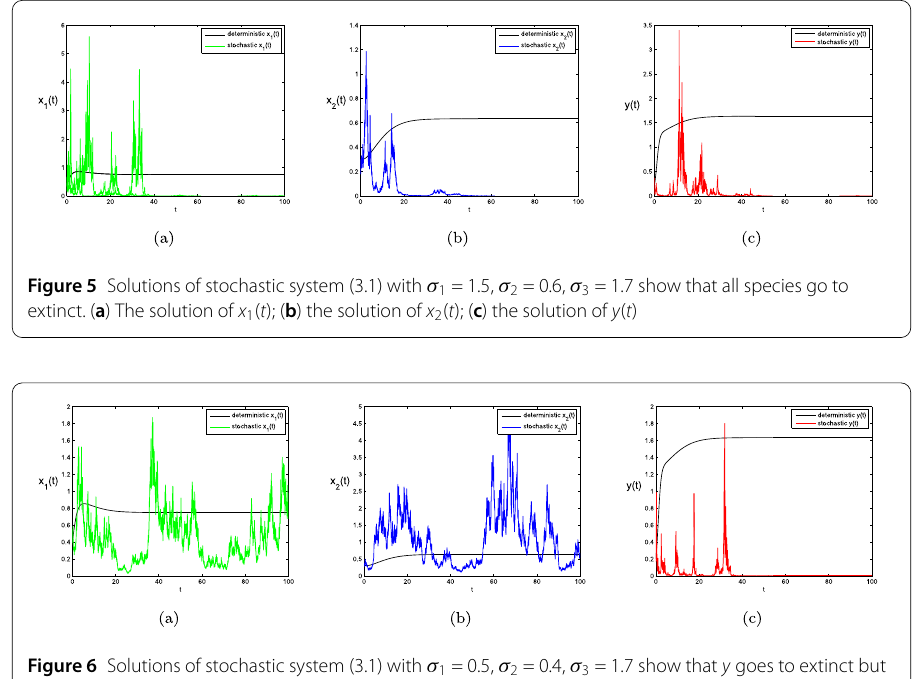
Figure 6 Solutions of stochastic system (3.1) with σ 1 = 0.5, σ 2 = 0.4, σ 3 = 1.7 show that y goes to extinct but x 1 and x 2 persist. ( a ) The solution of x 1 ( t ); ( b ) the solution of x 2 ( t ); ( c ) the solution of y ( t